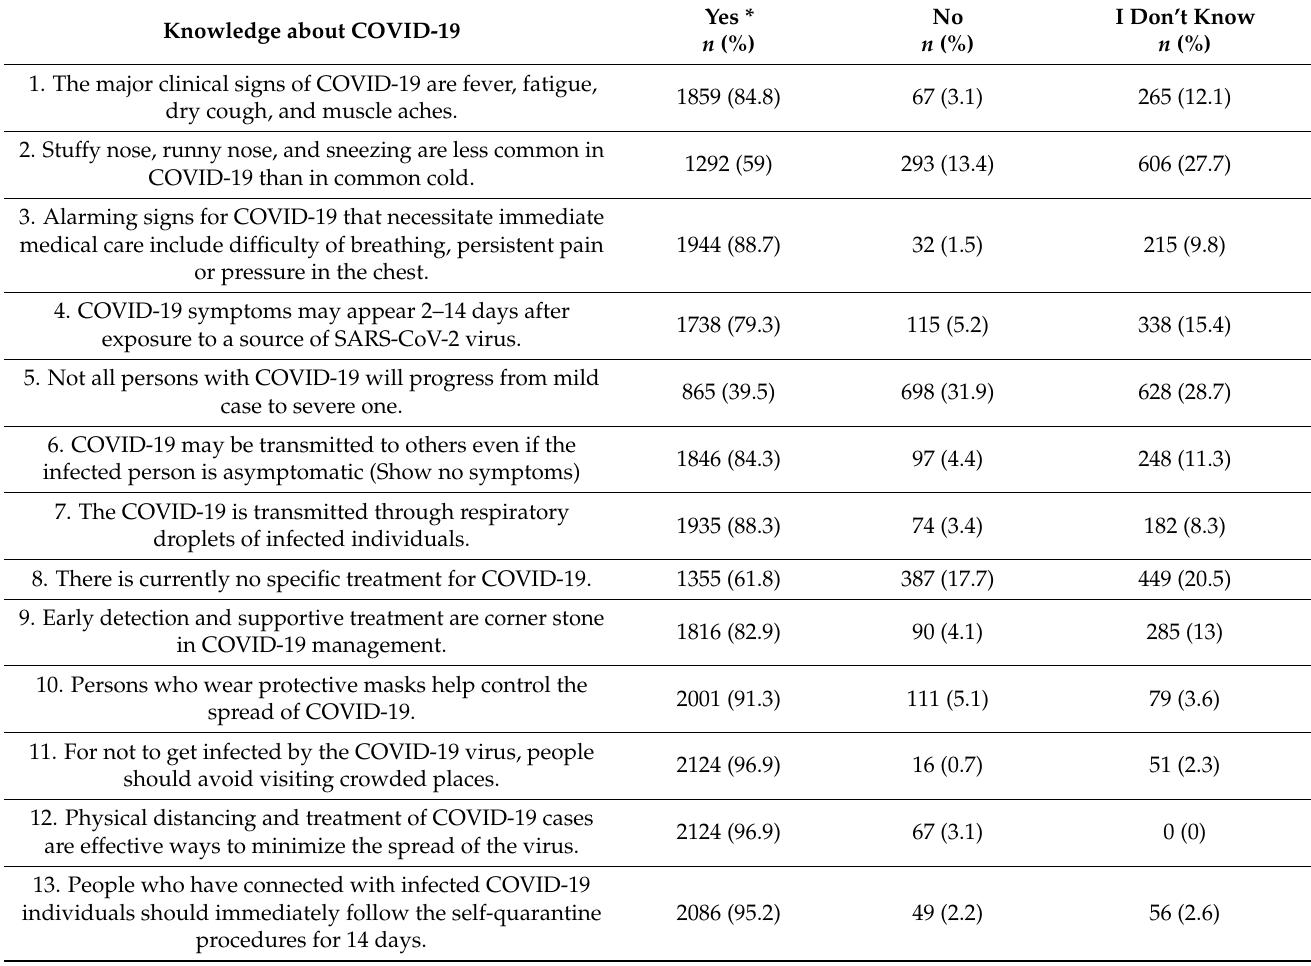
Table 2. Knowledge of the survey population about